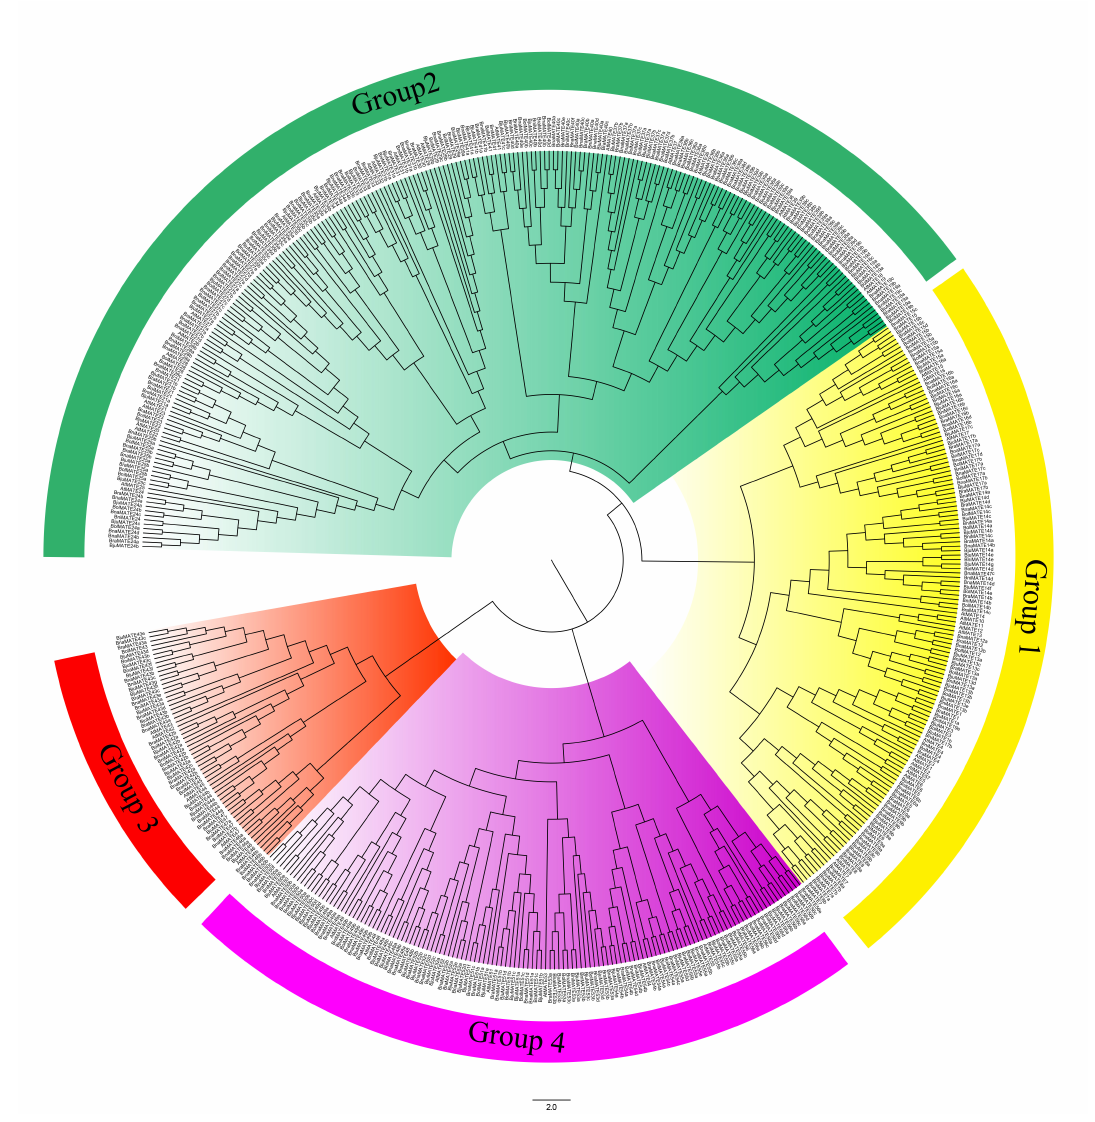
Figure 1. Phylogenetic analysis of the multidrug and toxic compound extrusion (MATE) transporters. The rooted neighbor-joining phylogenetic tree was constructed using MEGA7.0 and visualized using Figure Tree v1.4.2. There are 556 MATEs in A. thaliana and five Brassicaceae species, including 57 AtMATEs, 124BnaMATEs, 85BraMATEs, 81BolMATEs, 79BniMATEs, and130BjuMATEs. TheseMATE transporters are divided into four subgroups, Groups 1–4, which are marked in yellow, green, red, and purple, respectively. The outer circle represents the four